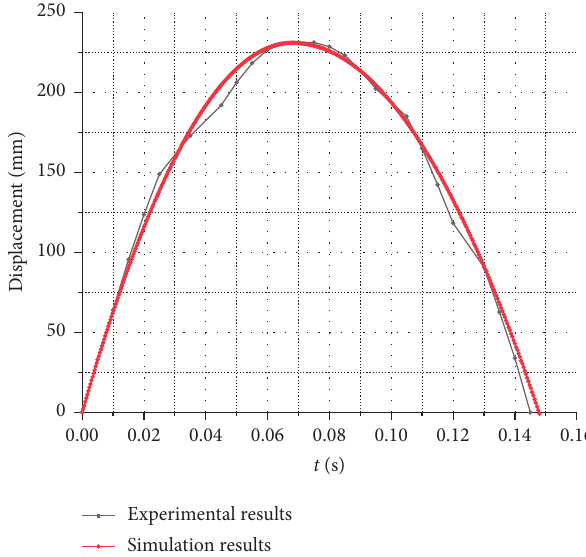
Figure 16: Comparison of the displacement-time history curves of the 1st coil.